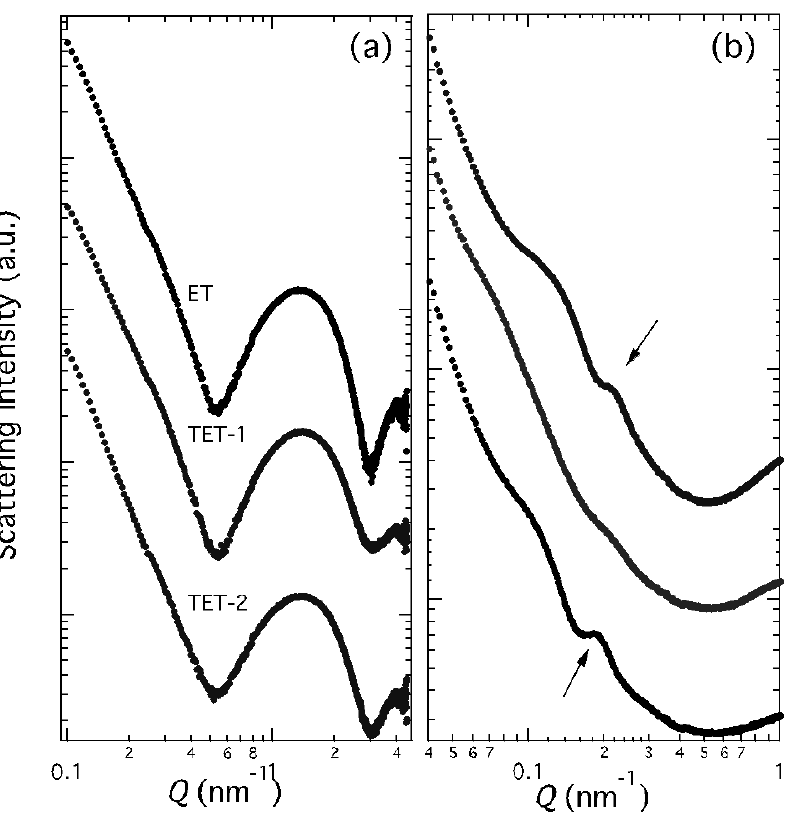
Figure 3. SAXS profiles observed at 35 °C for ET, TET-1 and TET-2 vesicles, as indicated. Panels ( a ) and ( b ) only differ for the investigated Q range. Arrows in panel ( b ) indicate the main diffraction peaks.